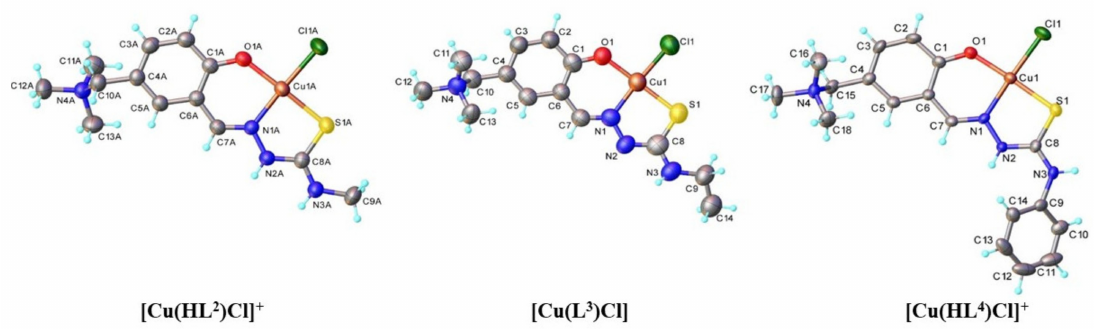
Figure 3. ORTEP (Oak Ridge Thermal-Ellipsoid Plot Program) view of the complexes [Cu(HL Me )Cl] +